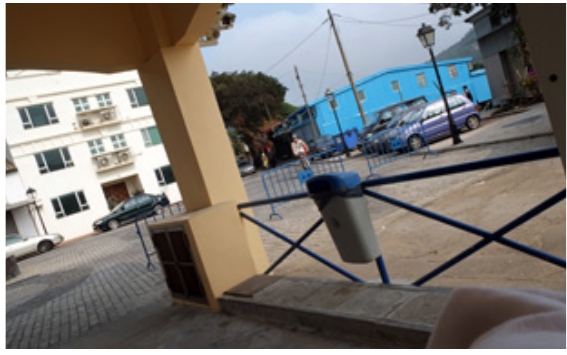
FIGURE 3 | Écho 3, Jerry Chan, 18 th Mar. 2013 Port de Coloane